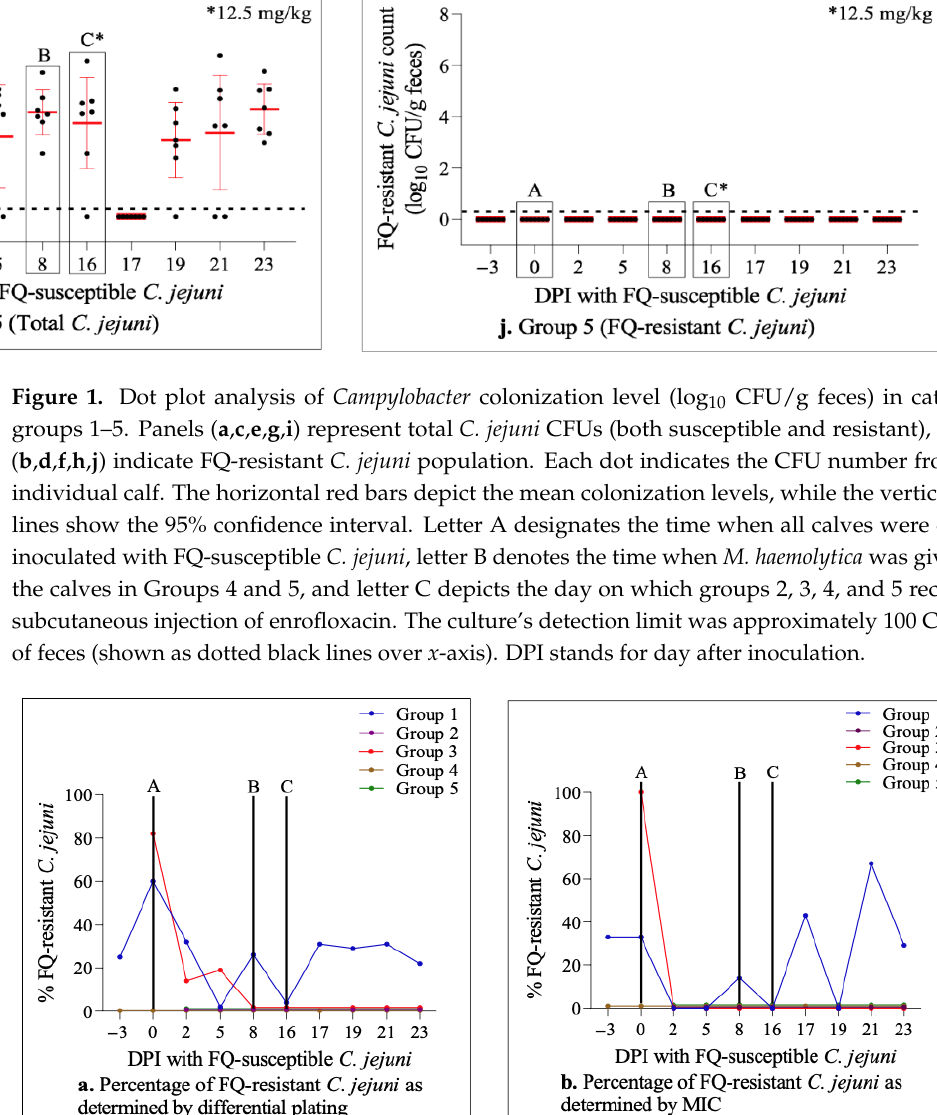
Figure 2. The proportions of FQ-resistant C. jejuni colonies in colonized calves as determined by differential plating ( a ) and MIC assays ( b ). The 5 groups are represented by lines of different colors. See the legend of Figure 1 for letters A, B, and C.